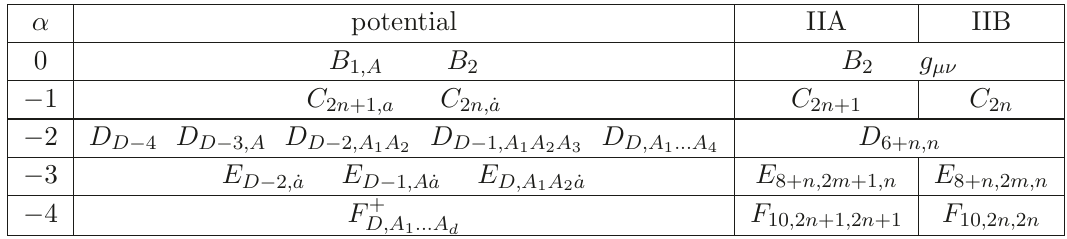
Table 1 . The potentials associated to the branes that satisfy the wrapping rules in eqs. (1.2) and (1.3) for the different values of α . In the second column we list the D -dimensional potentials as representations of SO( d, d ), while in the third and fourth we give the corresponding mixed-symmetry potentials for both the IIA and IIB theory. For α = 0 and α = − 2 the potentials for IIA and IIB are the